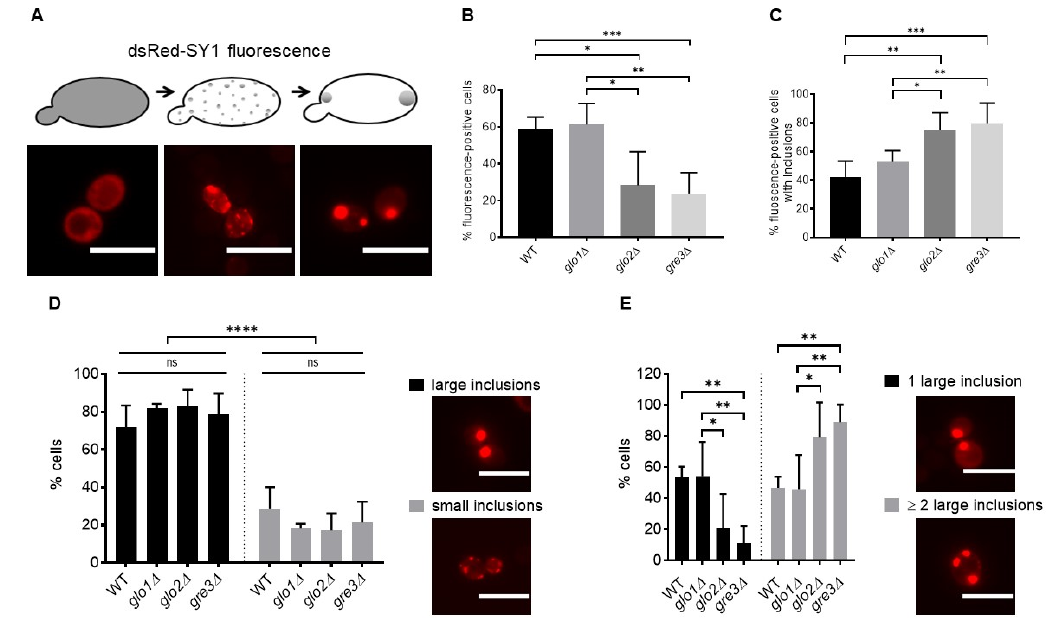
Figure 3. Analysis of the repercussions of a disrupted methylglyoxalase system and aldose reductase activity on SY1 inclusion characteristics in S. cerevisiae . dsRed ‐ SY1 forms consecutively small oligomers and larger membrane ‐ localised aggregates in wt S. cerevisiae [14] ( A ). The percentage of wt, glo1 ∆ , glo2 ∆ , and gre3 ∆ cells displaying dsRed ‐ SY1 fluorescence ( B ), dsRed ‐ SY1 fluorescence and inclusions ( C ), small or large dsRed ‐ SY1 inclusions ( D ), and multiple large dsRed ‐ SY1 inclusions ( E ) was calculated. Data represent the combined results of at least 800 counted cells of three clones per strain. Error bars represent the standard deviations based on these counts. Significance is based on the total number of cells and determined using a one or two ‐ way ANOVA test ( p ‐ value of 0.05, significance indicated by the asterisk; n = 3, * = p < 0.05, ** = p < 0.01, *** = p < 0.001, **** = p < 0.0001). Non ‐ indicated differences between strains are not significant. The scale bars represent 10 μ m. SY1 = Synphilin ‐ 1; ns = not significant.